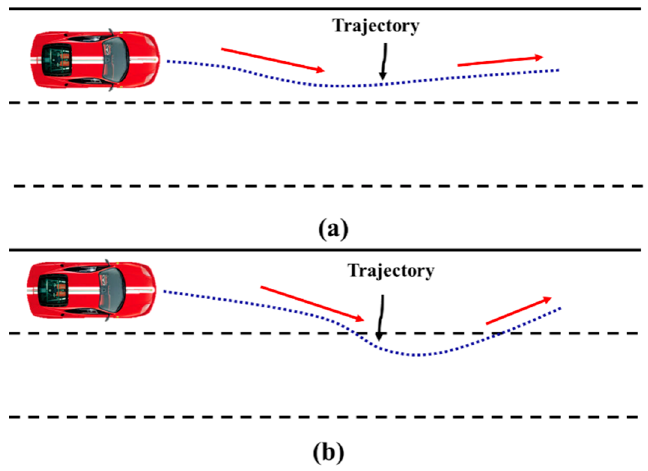
Figure 4. Vehicle trajectory of ( a ) driver correction behavior (DCB) and ( b ) proactive correction after slight departure (PCSD).